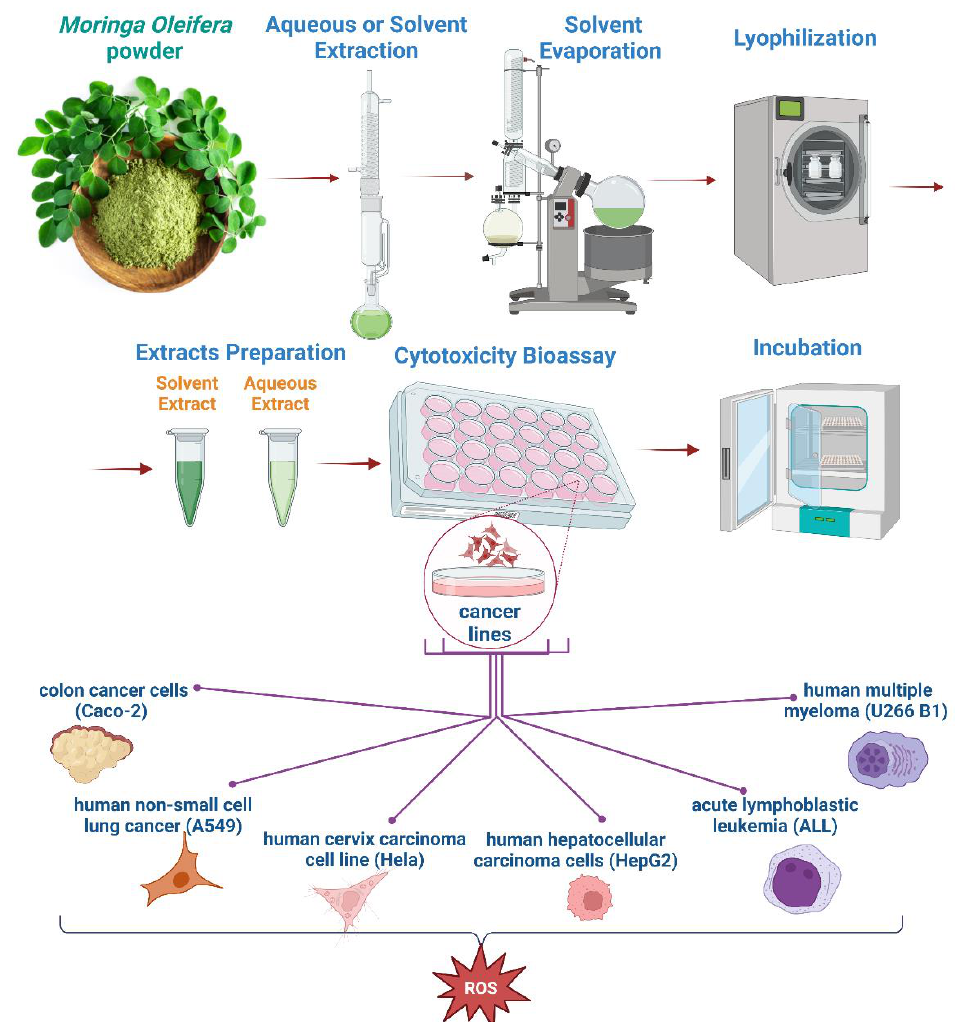
Figure 1. Cytotoxicity bioassay of M. oleifera (created with BioRender.com). The Moringa leaves were encapsulated by spray drying with tragacanth gum as a carrier to increase the bioactivity and bioaccessibility of the compounds. The total polyphenolic content, antioxidant activity, and cytotoxicity (on colon cancer cells—Caco-2) were evaluated on the microencapsulated Moringa. After the in vitro digestion, the total polyphenolic content increased gradually from the mouth (9.7%) to the stomach environment (35.2%) and intestinal one (57.6%). The highest antioxidant activity was associated with the intestinal phase. Regarding cytotoxicity, the Caco-2 cells were tested on microencapsulated and nonencapsulated M. oleifera extract. After 48 h of incubation, at the highest concentration (0.125 mg mL − 1 ), cell viability was 82% for nonencapsulated and 87% for the encapsulated extract